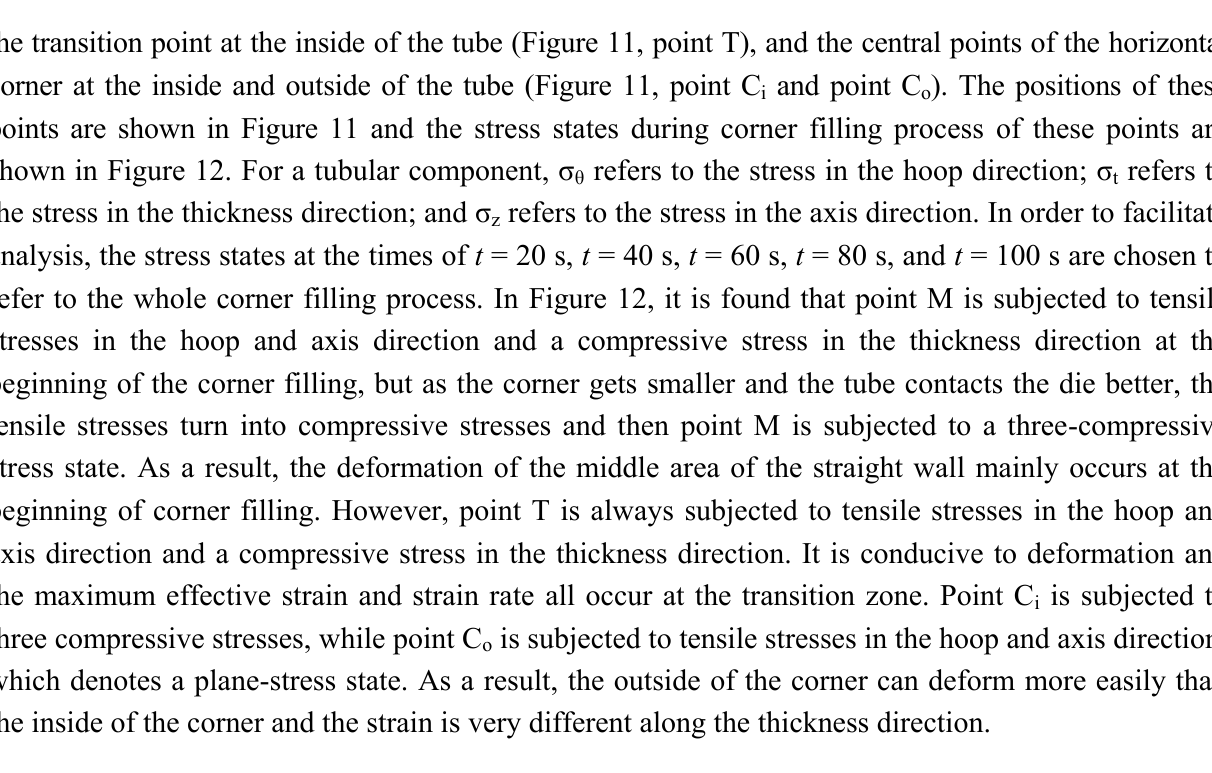
Figure 11. Position of typical feature points.